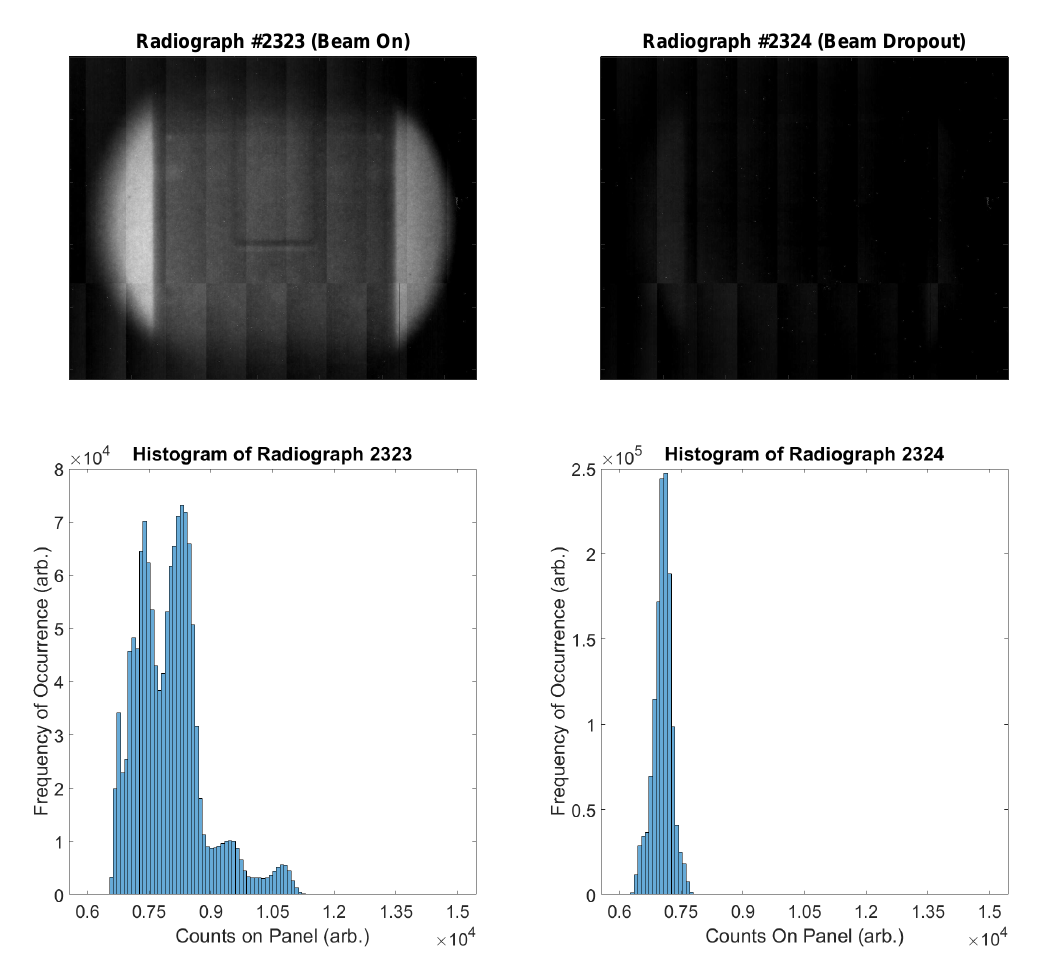
Figure 3. Consecutive neutron radiographs taken during the experiment. Top Left : Radiograph #2323, in which the beam is performing as expected. Top Right : Radiograph #2324, in which nearly total beam dropout has occurred. Bottom Left : Histogram of Radiograph #2323, restricted to the range of [6000, 15,000] for clarity. Bottom Right : Histogram of Radiograph #2324, restricted to the range of [6000, 15,000] for